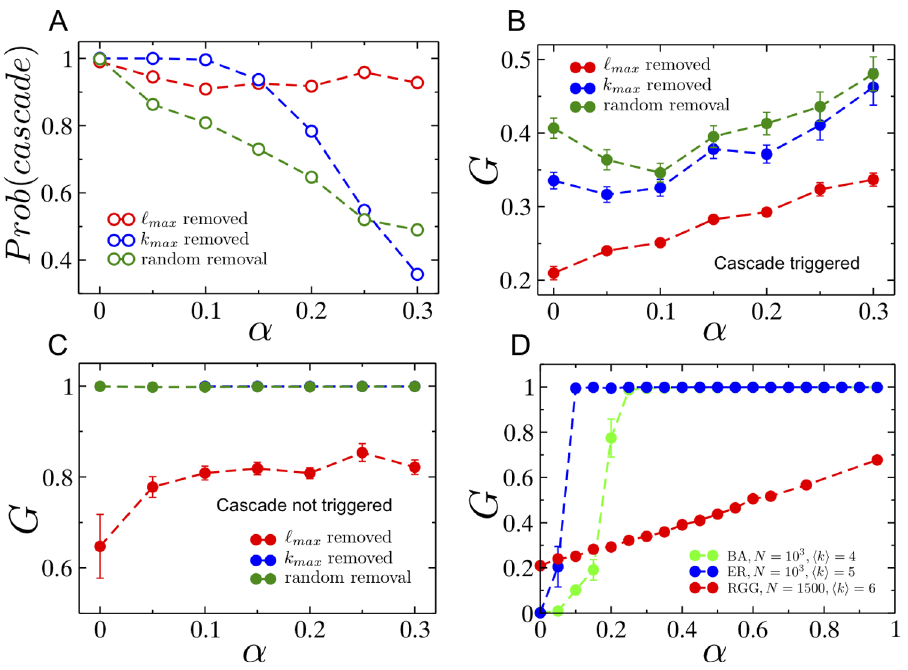
Figure 3. Cascades triggered by targeted and random removals. (A) Probability that a single node removal will trigger a cascade as function of the tolerance parameter. (B) The ratio G of the size of the largest surviving network component to the initial network size, as function of the tolerance parameter a , when the initial failure triggers a cascade. (C) Similar to (B), except for the case where the initial failure does not trigger a cascade. In all (A), (B) and (C) subplots the red curve corresponds to the case when the triggered node is the node with the highest load, the blue curve to the case when the triggered node is the most connected (highest degree) node in the network and the green curve shows the case when the triggered node was chosen randomly. Network parameters are N ~ 1500 , S k T ~ 6 : 0 , while the data was averaged over 500 network realizations. Error bars correspond to the standard error of the mean. (D) G as a function of tolerance parameter, unconditioned on whether or not a cascade was triggered for RGGs, SF networks and ER networks. For each point, the data was averaged over 500 network realizations.